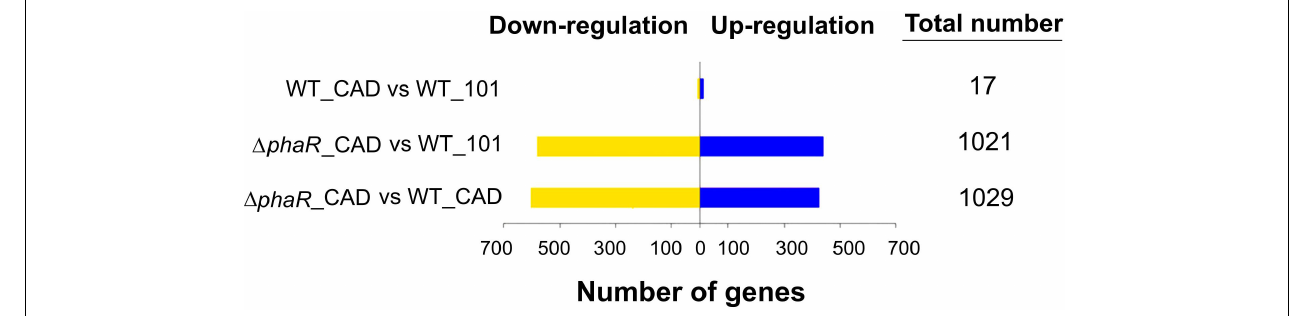
FIGURE 5 | The number of up- and down-regulated genes in pairwise comparison between the